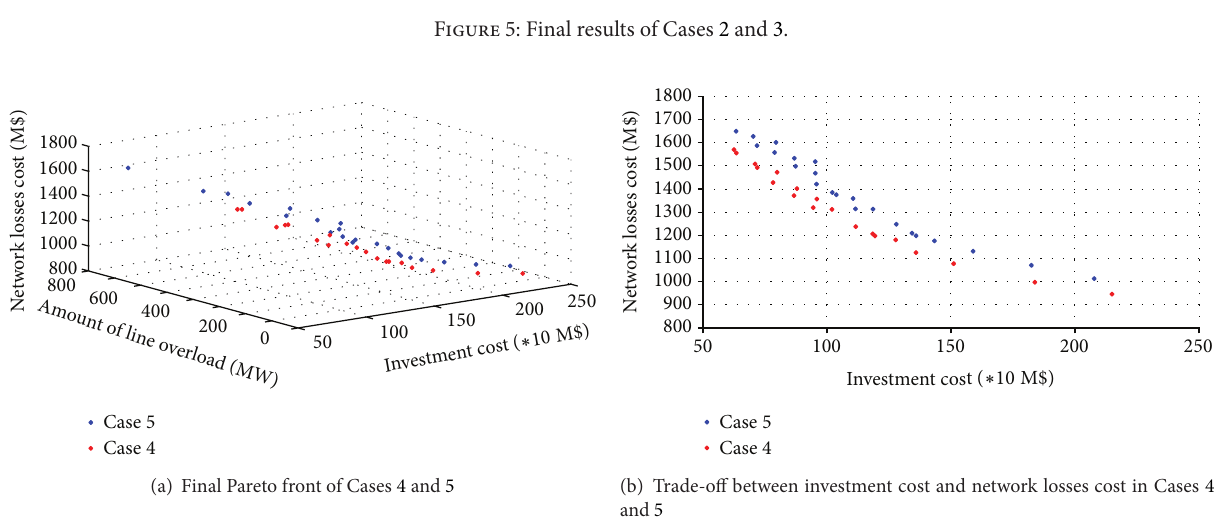
Figure 6: Final results of Cases 4 and 5.